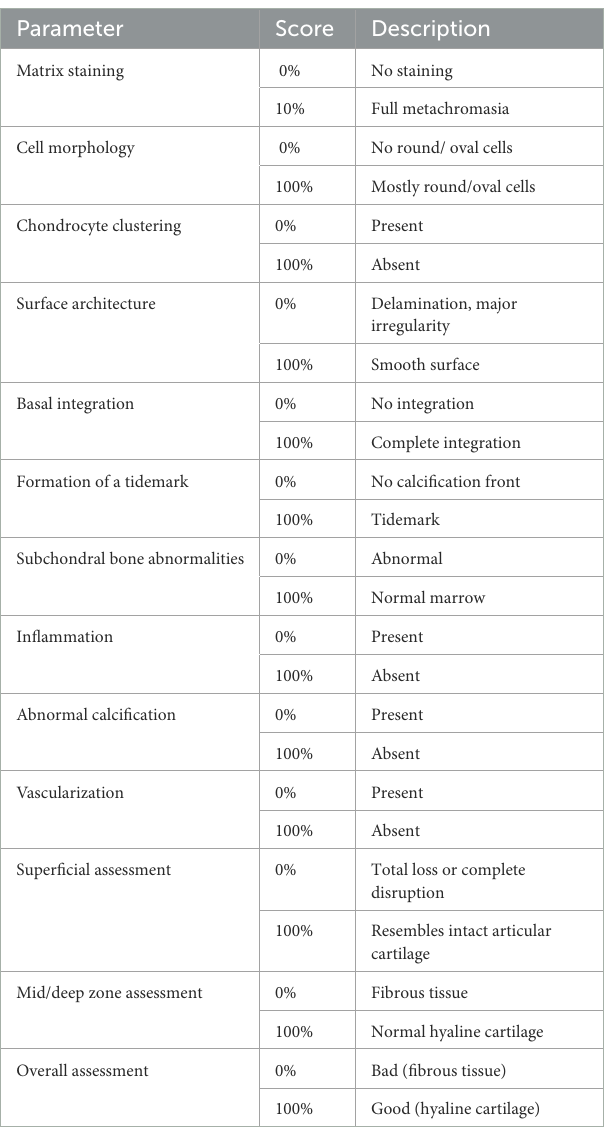
TABLE 2 ICRS II parameters and scores